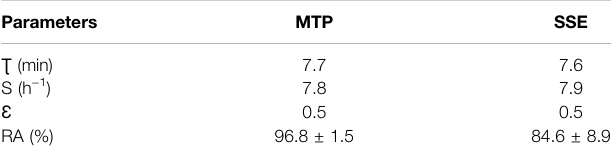
TABLE 3 | Operational parameters of PBR process for the treatment of MTP and SSEef fl uentsfromthetanningindustryusingCa-alginatederivativecontaining A. fumigatus CAS21 tannase.